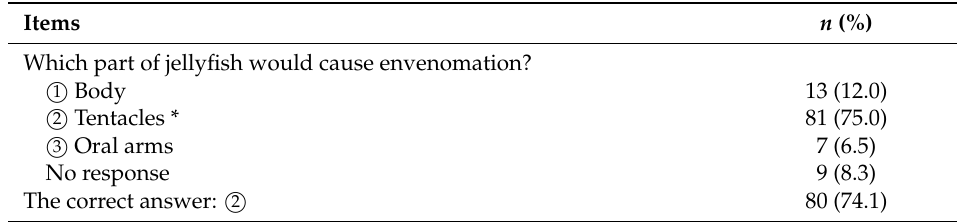
Table 2. General knowledge about jellyfish envenomation ( n =